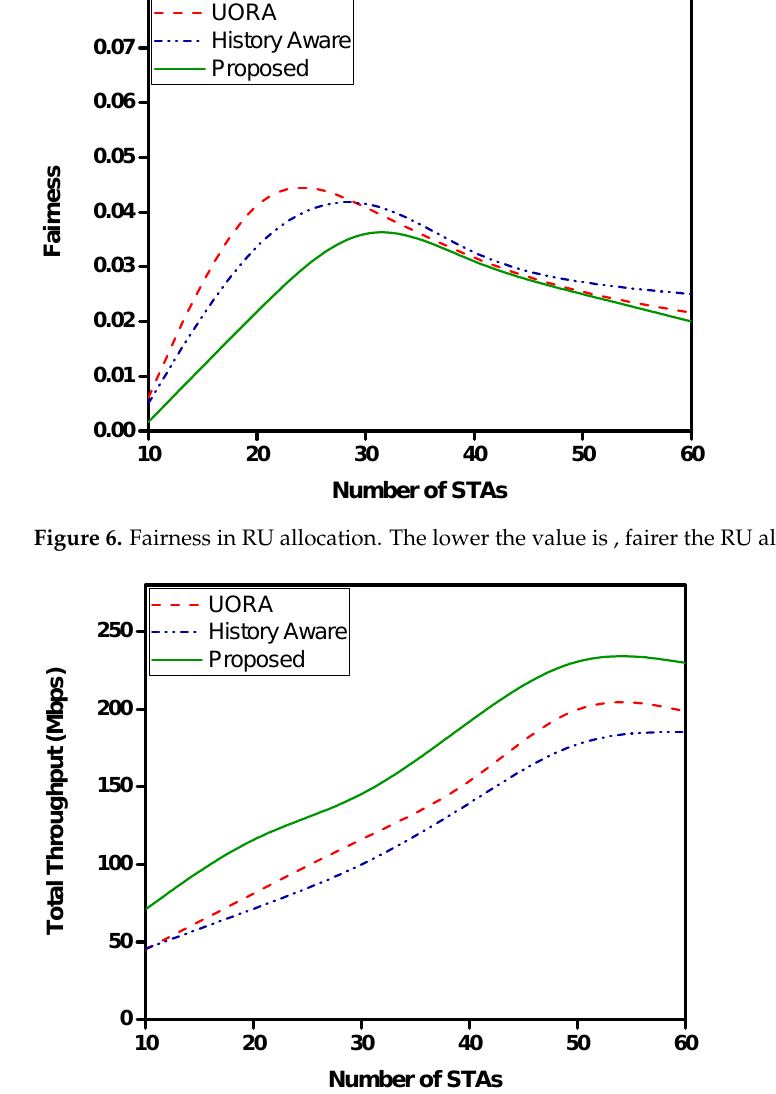
Figure 7. Average throughput achieved. The increase in the number of STAs increases the total average